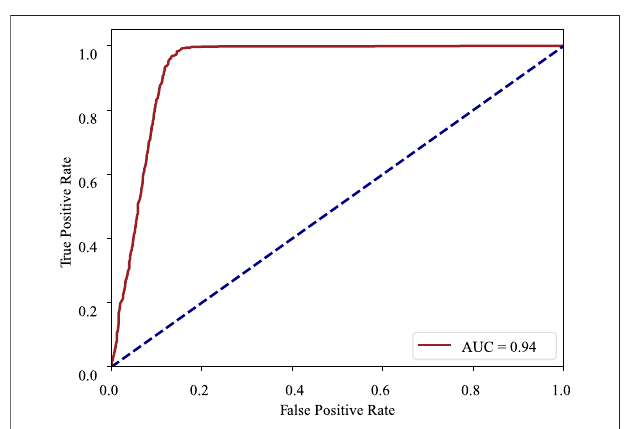
FIGURE 4 | ROC curve of DR diagnosis on the APTOS 2019 dataset.